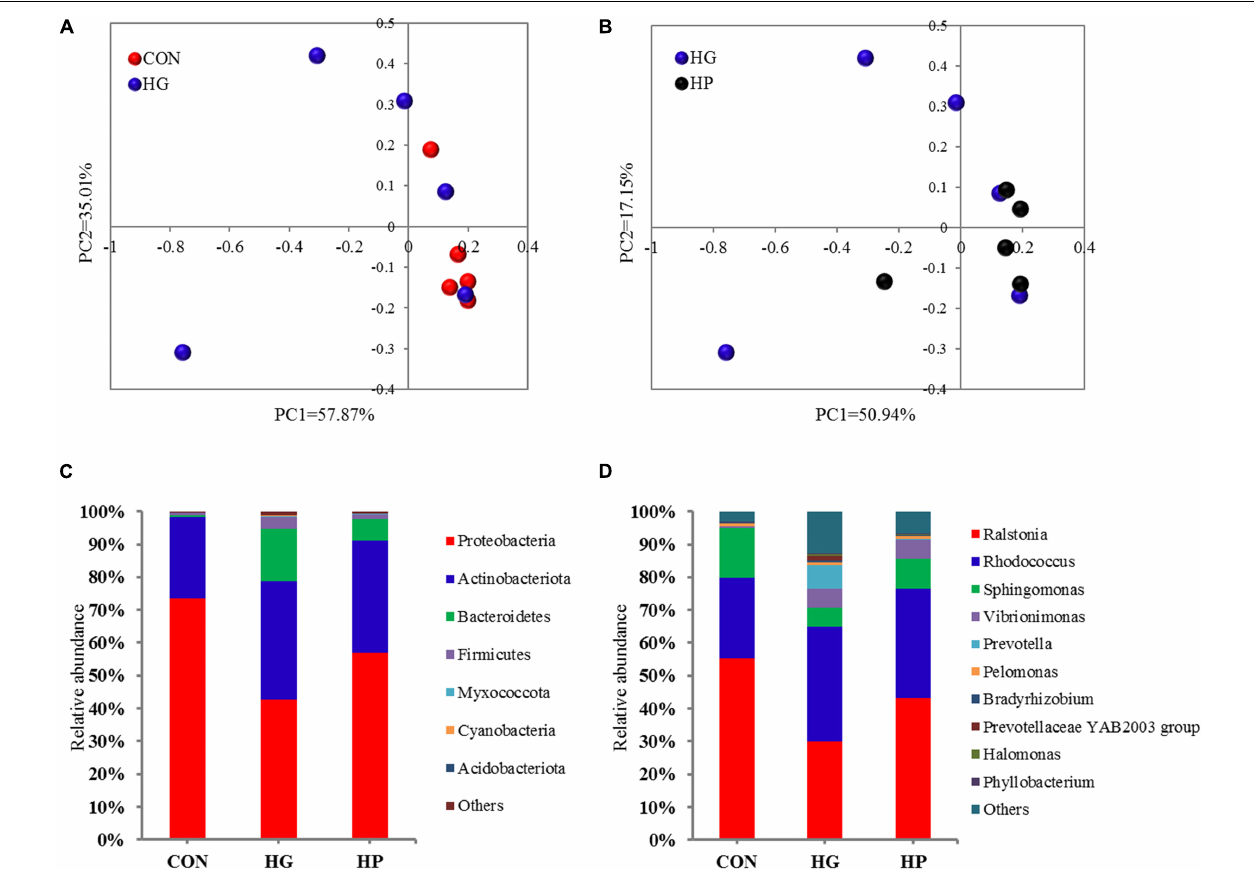
FIGURE 1 | Taxonomic analysis of the microbial communities in the ileal mucosa of Hu sheep fed CON, HG, and HP diets. Principal coordinate analysis (PCoA) score plots of the samples from the CON and HG group (A) and the HG and HP group (B) based on the Bray-Curtis similarity metric. The composition of the ileal mucosal microbiota at the phylum (C) and genus (D)